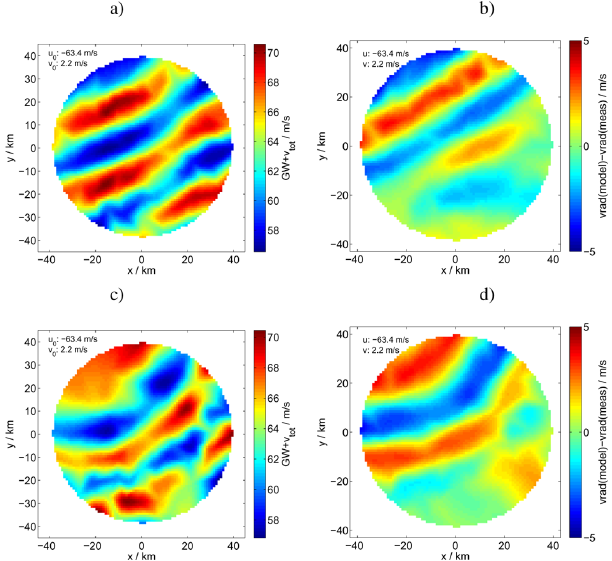
Fig. 9. Simulation of prevailing wind and superimposed gravity waves considering the sampling time of the multi-beam experi- ments. (a) shows mean wind plus gravity waves for a 25s time shift for each experiment. (b) indicates radial velocities after subtracting the mean winds. (c) and (d) are computed assuming the same pre- vailing wind and gravity waves, but for a time shift of 125 s between the experiments.